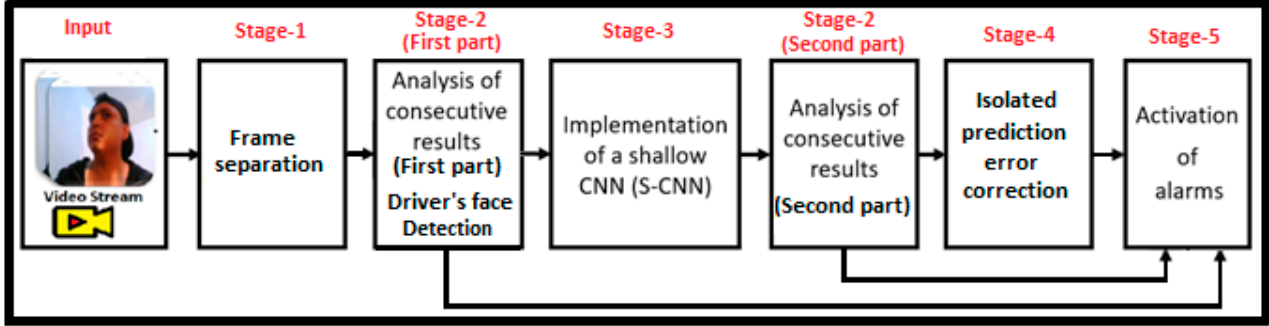
Figure 1. Proposed driver’s drowsiness and distraction detection system.